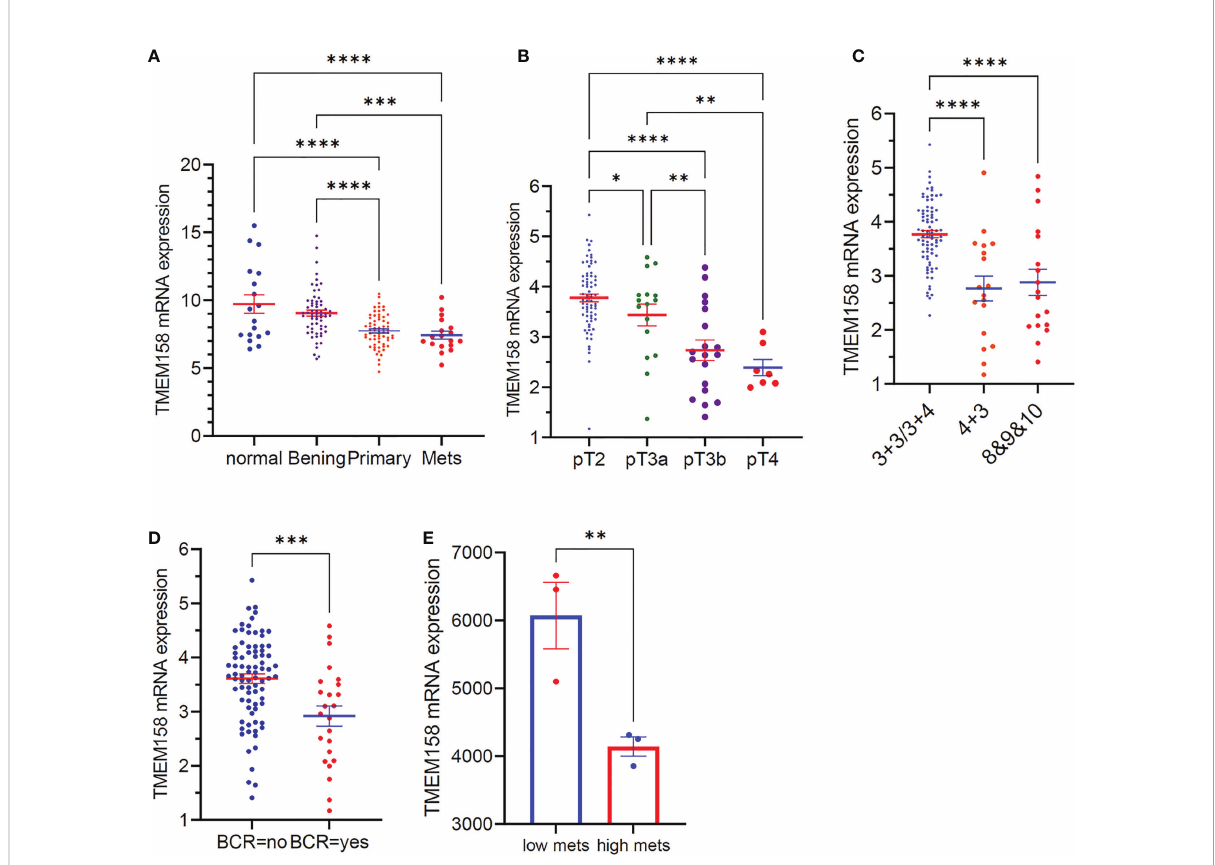
FIGURE 3 TMEM158 downregulation is associated with disease progression in prostate cancers. (A) TMEM158 expression was analyzed using the Affymetrix Human Genome U95 Version 2 Array. Data were extracted from NCBI GDS2545 (33, 34). Case number: normal = 18, benign = 63, primary tumor = 65, metastasis = 18. (B – D) TMEM158 expression RNA-seq data were extracted from a cohort of 292 early-onset prostate cancer patients on the cBioportal platform (20). Case number: pT2 = 74, pT3a = 16, pT3b = 19, pT4 = 7; Gleason score category 3 + 3/3+4 = 82, 4 + 3 = 18, 8and 9and 10 = 18; BCR-no = 81, BCR-yes = 24. (E) TMEM158 expression data were extracted from NCBI GDS2865 in PC-3 cell xenografts with low or high metastatic potential (29). Gene expression data were obtained using Affymetrix Human Genome U133A Array (n = 3). The asterisks indicate